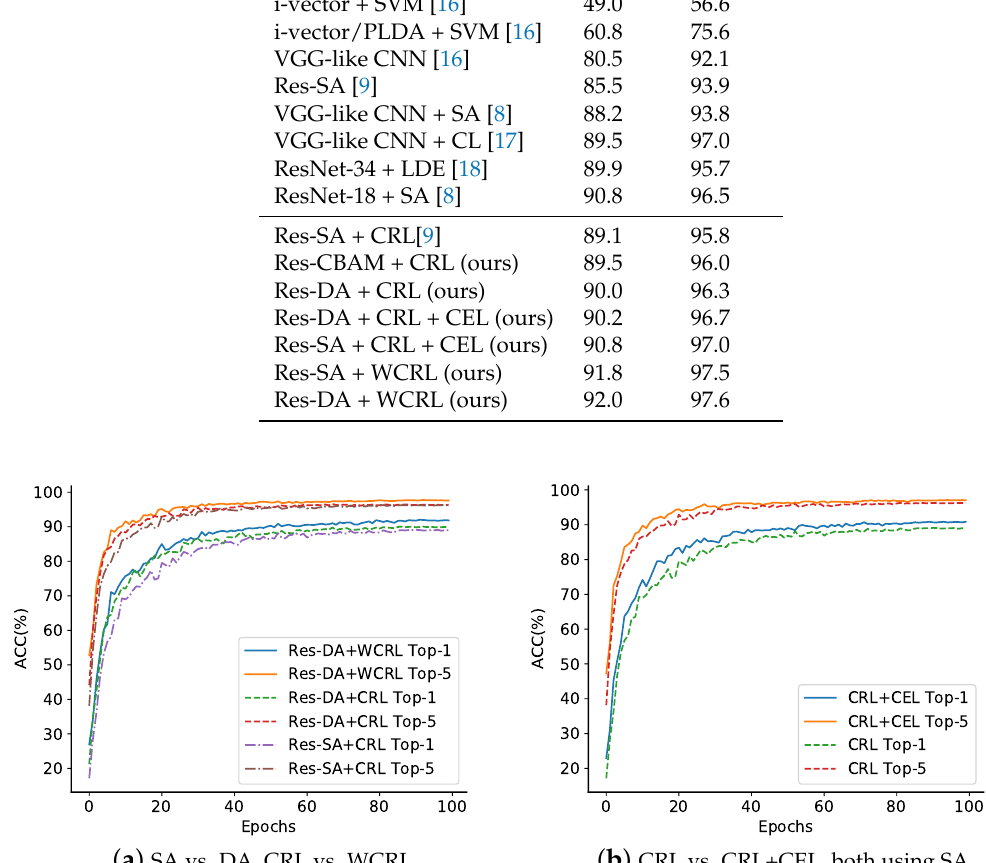
Figure 7. ACC curves of different configurations. CEL, Criticality-Enhancement